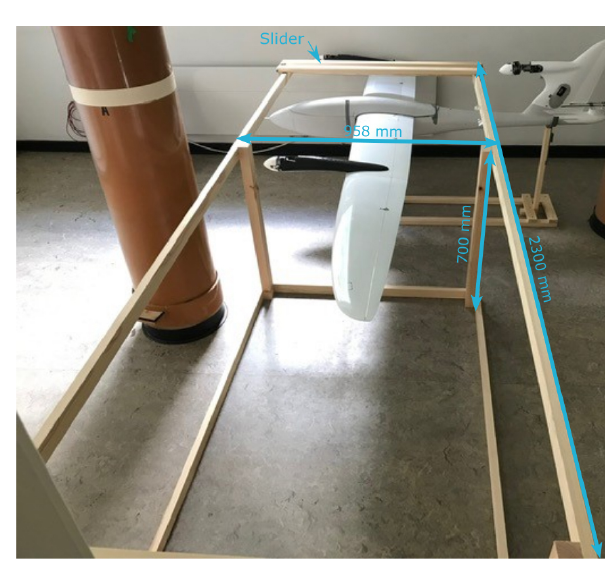
Figure 2. Demonstration of the magnetic signature measurement of the port wing. The length and the width of the slider are 1000 and 150mm,